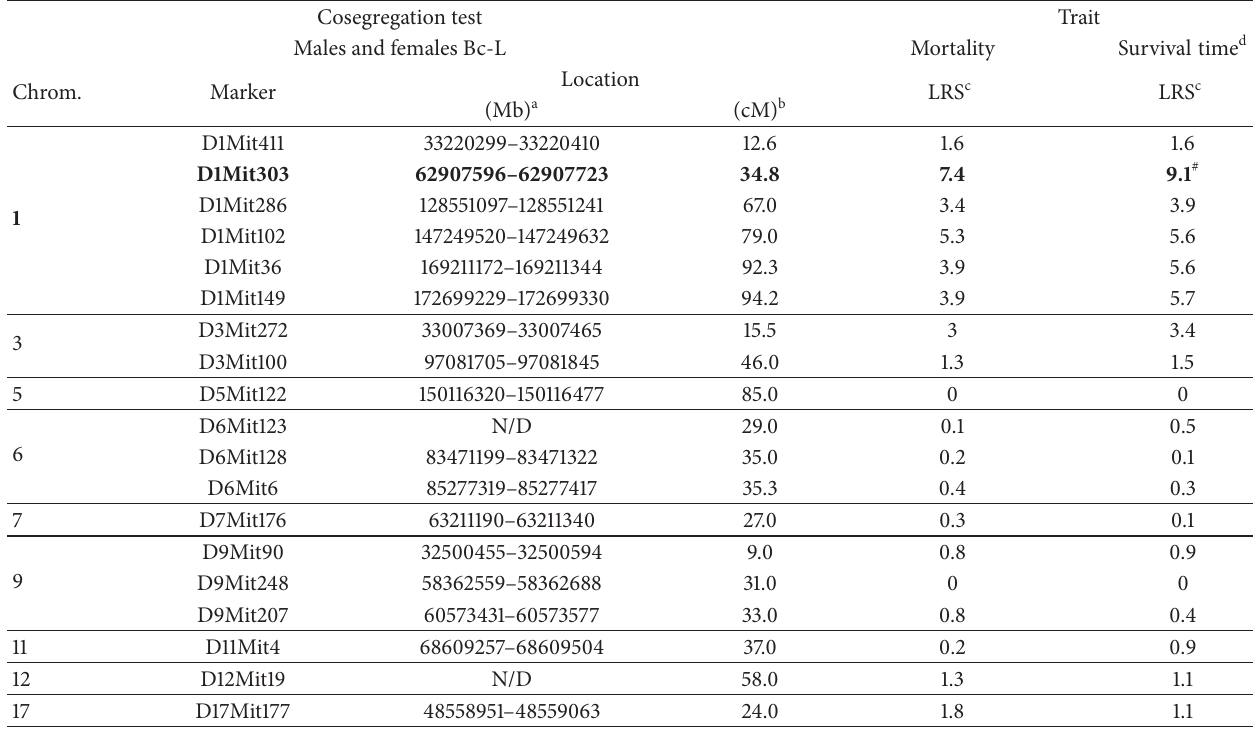
Table 1: Significance of cosegregation between mortality and survival time traits with microsatellites markers of Ab regulating QTLs (quantitative trait loci) from Selection III or with candidate region markers of T. cruzi infection susceptibility.